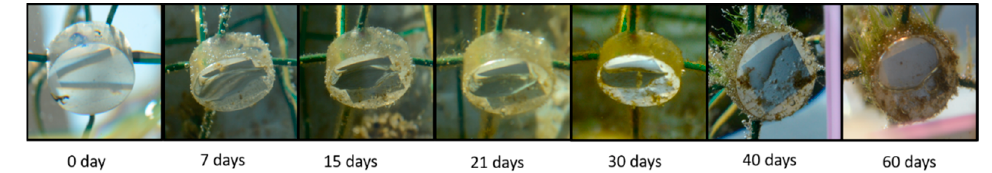
Figure 2. Image sequence of bubble formation over the observation period.